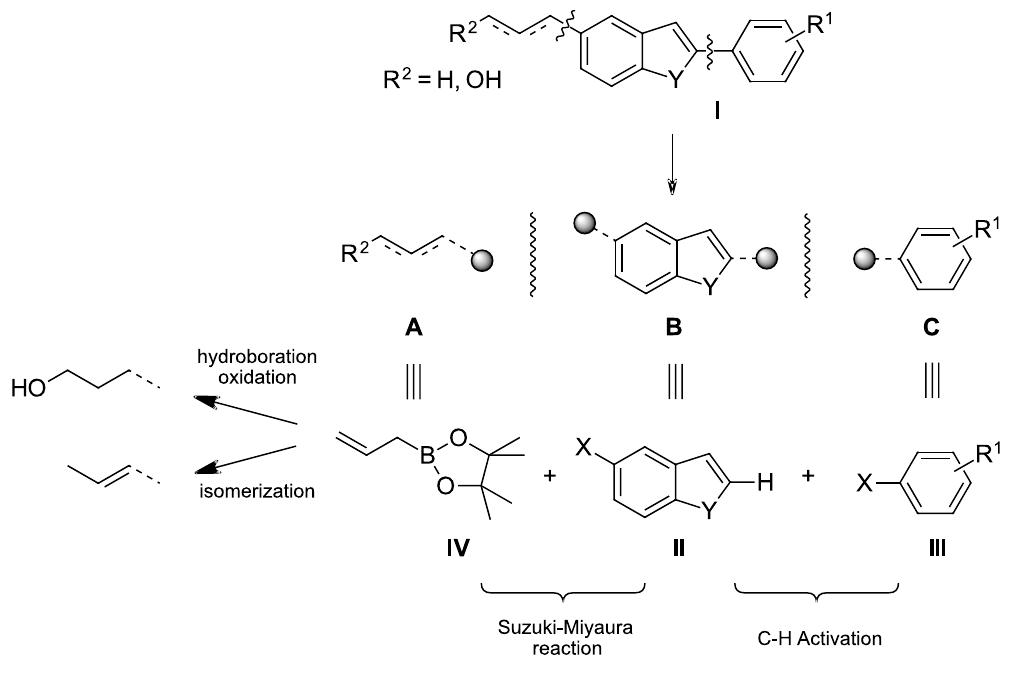
Figure 2. Retrosynthetic analysis.